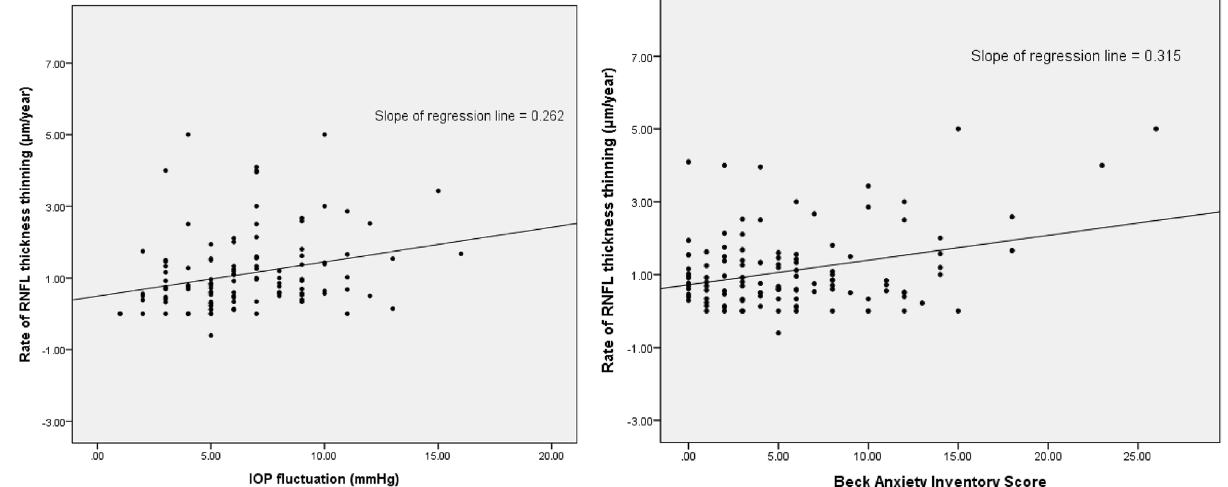
Figure 1. Scatter plot showing the relationships between the rate of RNFL thinning and IOP fluctuations (left) and Beck Anxiety Inventory scores